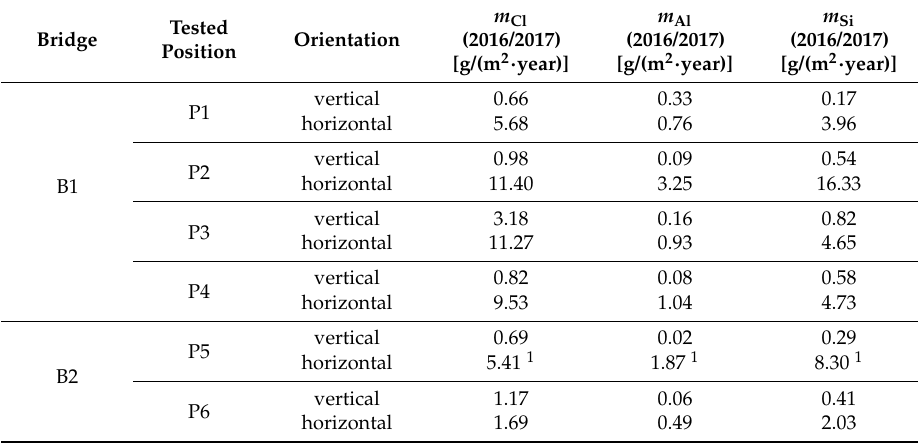
Table 5. Content of individual elements in corrosion products [g · m − 2 · year − 1